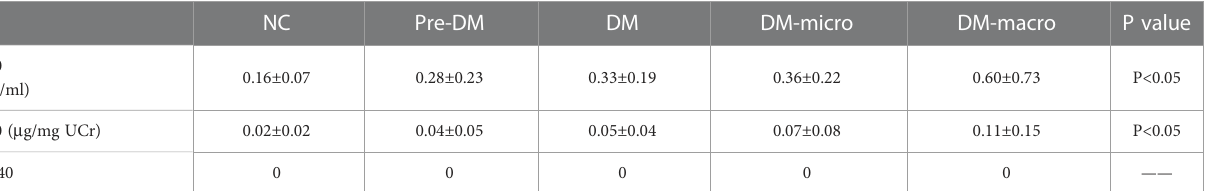
TABLE 2 Protein concentrations of uEVs in normal controls and diabetes (Mean±SD).